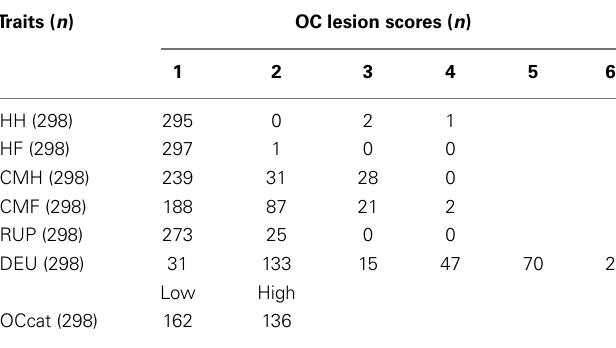
Table 2 | Phenotype distribution of osteochondrosis (OC) lesion scores among the animals of the large white